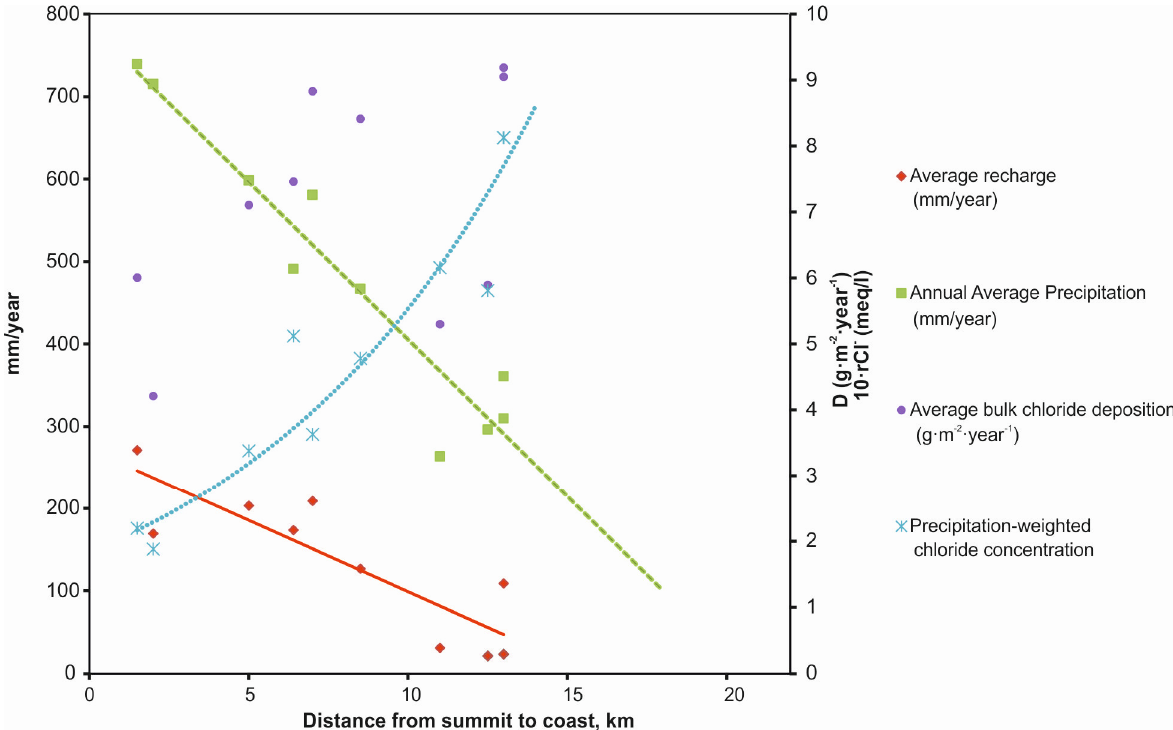
Figure 6. Long-term average recharge, annual average precipitation (period 1970–2014), average bulk chloride deposition and precipitation-weighted chloride concentration of rainwater vs. distance to the coast during the study